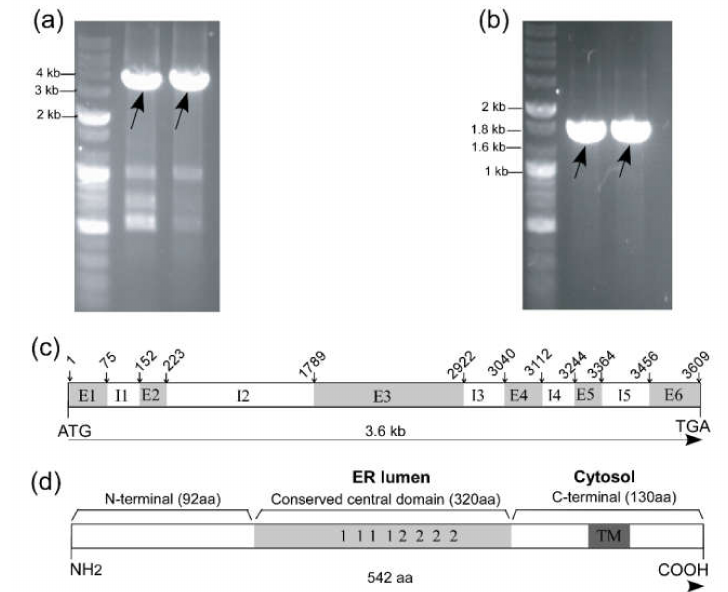
Figure 1. Isolation and identification of the TrCNX1 gene in Tradescantia . ( a ) PCR amplification of TrCNX1 from genomic DNA. ( b ) PCR amplification of TrCNX1 ORF from cDNA of Tradescantia . Target-specific amplicons indicated by an arrow. ( c ) Structural analysis of the TrCNX1 gene. In TrCNX1 , the start (ATG) and stop (TGA) codons are shown in the gene coding region. The numbers above the TrCNX1 gene represent the DNA base pair (bp). Corresponding positions of introns (I) / exons (E) are indicated by arrows with the bp position. Numbers of introns (I1–I5) and exons (E1–E6) are denoted by white and gray boxes, respectively. ( d ) General structural features of the TrCNX1 protein. The putative conserved domains are shown according to previous reports [27]. The gray box indicates the conserved central domain of the endoplasmic reticulum (ER) lumen and those numbered 1 and 2 represent Ca 2 + -binding regions (motif 1) and oligosaccharide-binding domains (motif 2), respectively. The dark gray box represents the transmembrane (TM) domain in the cytosol. The size of each domain is denoted in closed brackets with amino acid (aa) residue